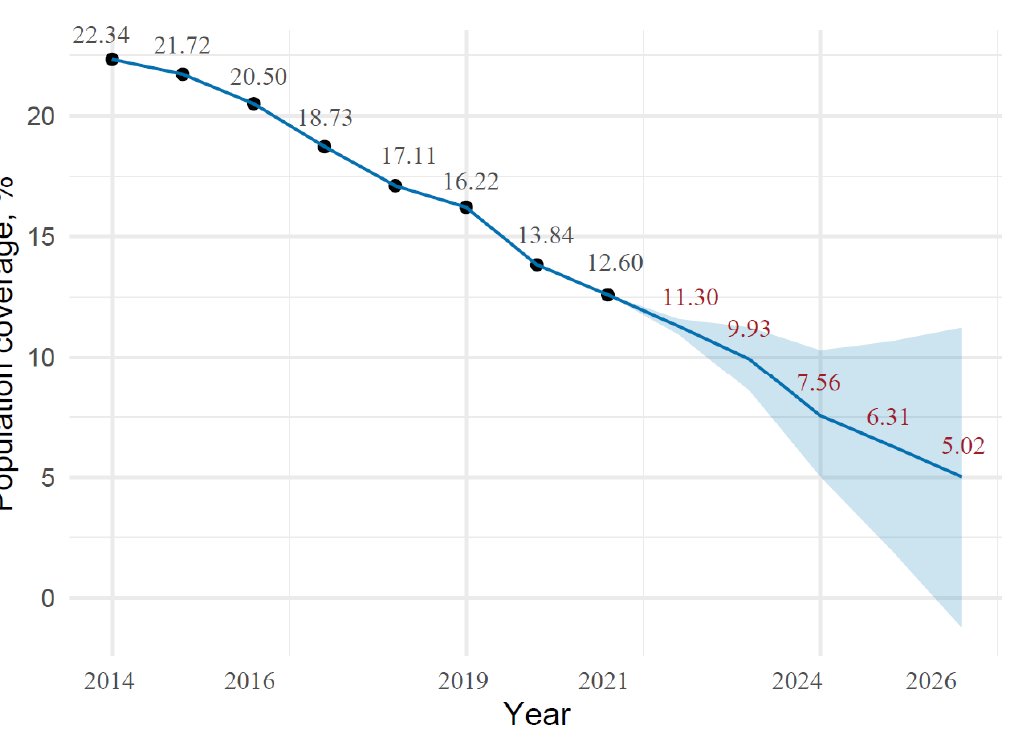
Table 6. Projection of population coverage for publicly funded cervical cancer screening as part of a prevention program in Poland. Year